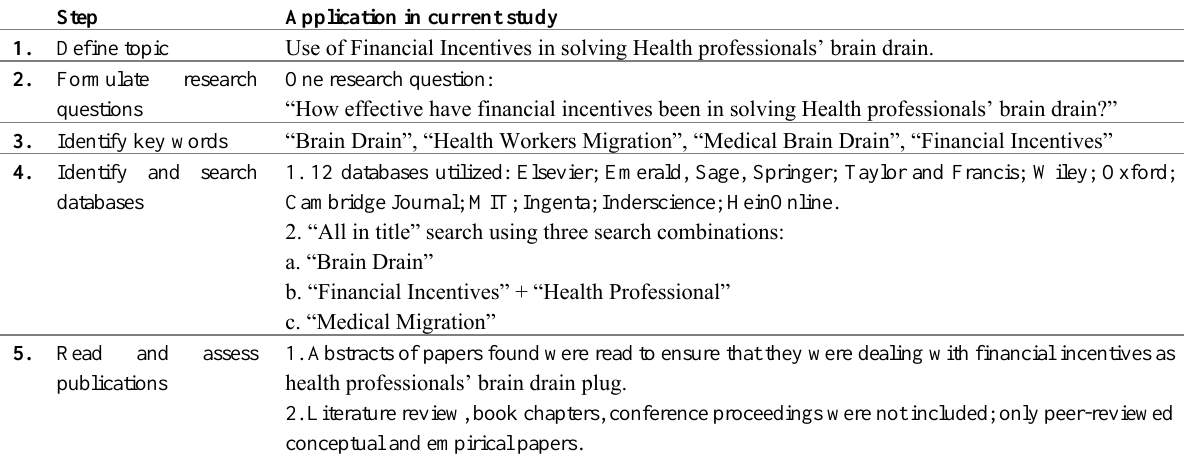
Table 1: Description and application of